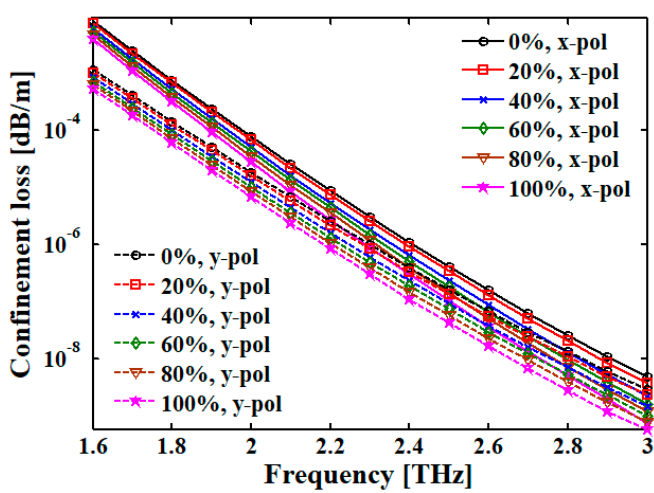
Figure 10. Confinement loss of the proposed sensor at optimum core length condition for different operating frequency.